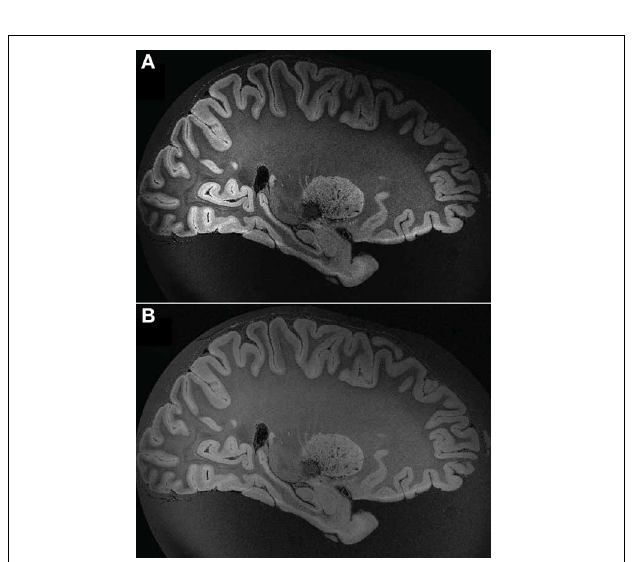
FIGURE 7 | Reconstruction comparison of sum-of-squares (A) and adaptive reconstruction (B).